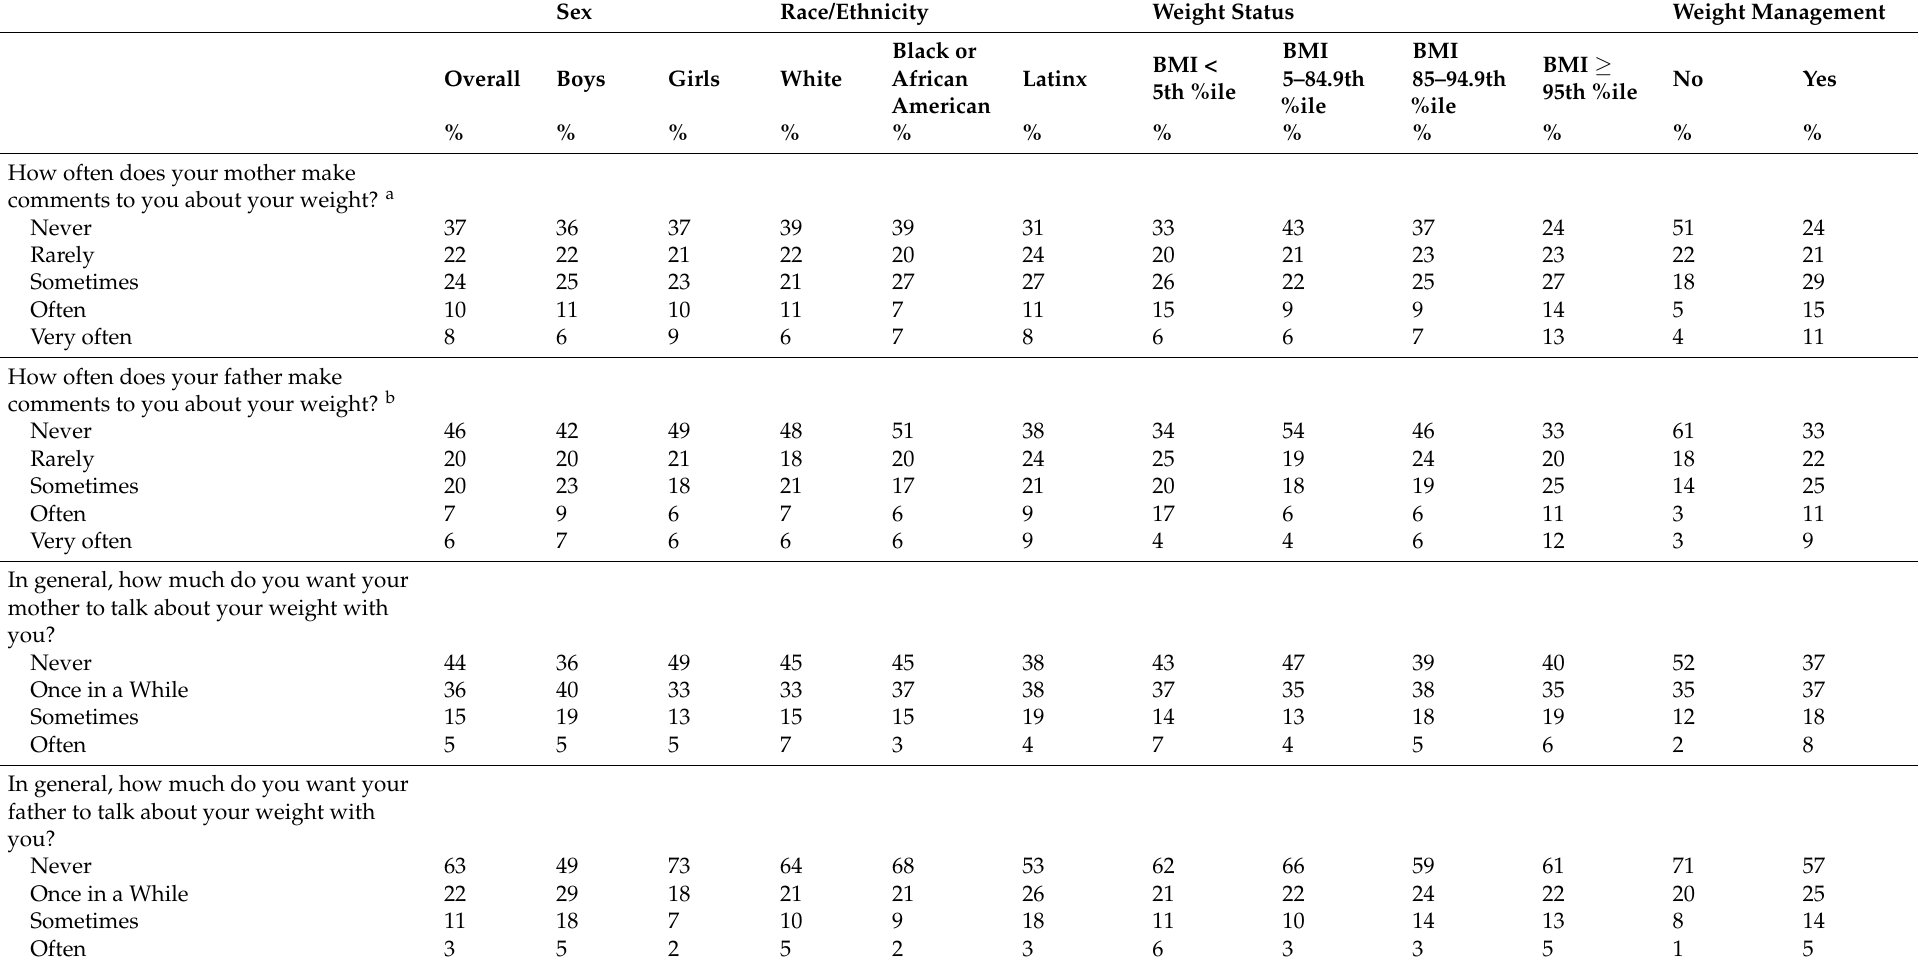
Table 3. Adolescent perceptions of and preferences for parental weight